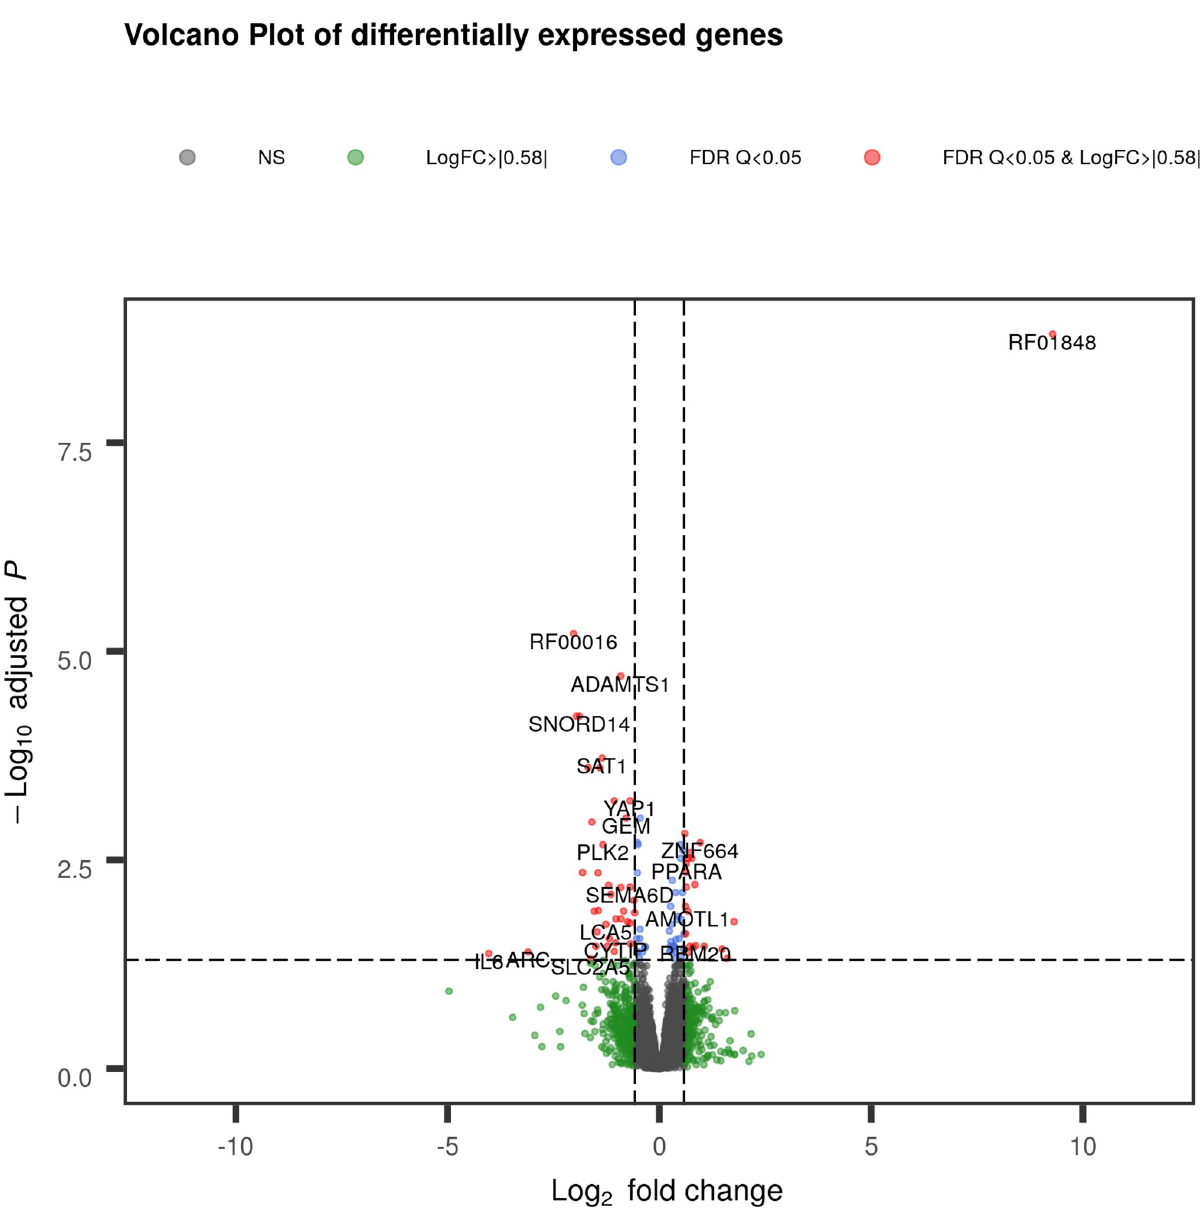
Fig 2. Volcano plot of differentially expressed genes (DEGs) of low Intramuscular Fat (IMF) vs . high IMF pigs. Red dots indicate DEGs with q < 0.05 and |Log 2 (Fold Change)| > 0.58; blue dots indicate genes with q < 0.05, green dots represent genes with |Log 2 (Fold Change)| > 0.58, grey dots are non-significant genes. The gene plotted as “SNORD14” refers to ENSSSCG00000039904 RF00016.